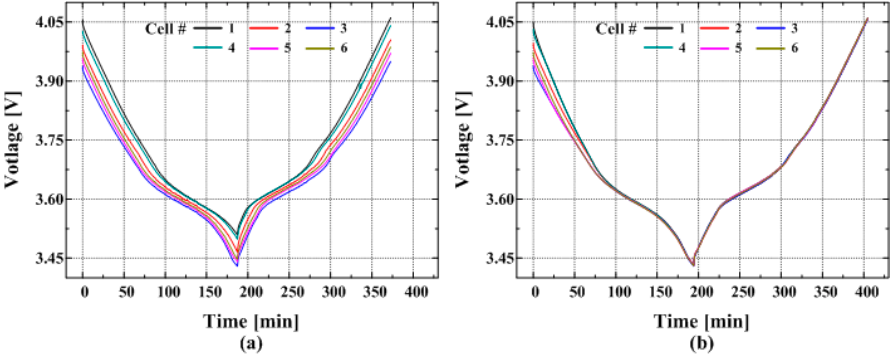
Figure 12. Voltage versus time under the one cyclic discharging / charging period: ( a ) without charge equalization, ( b ) with charge equalization.